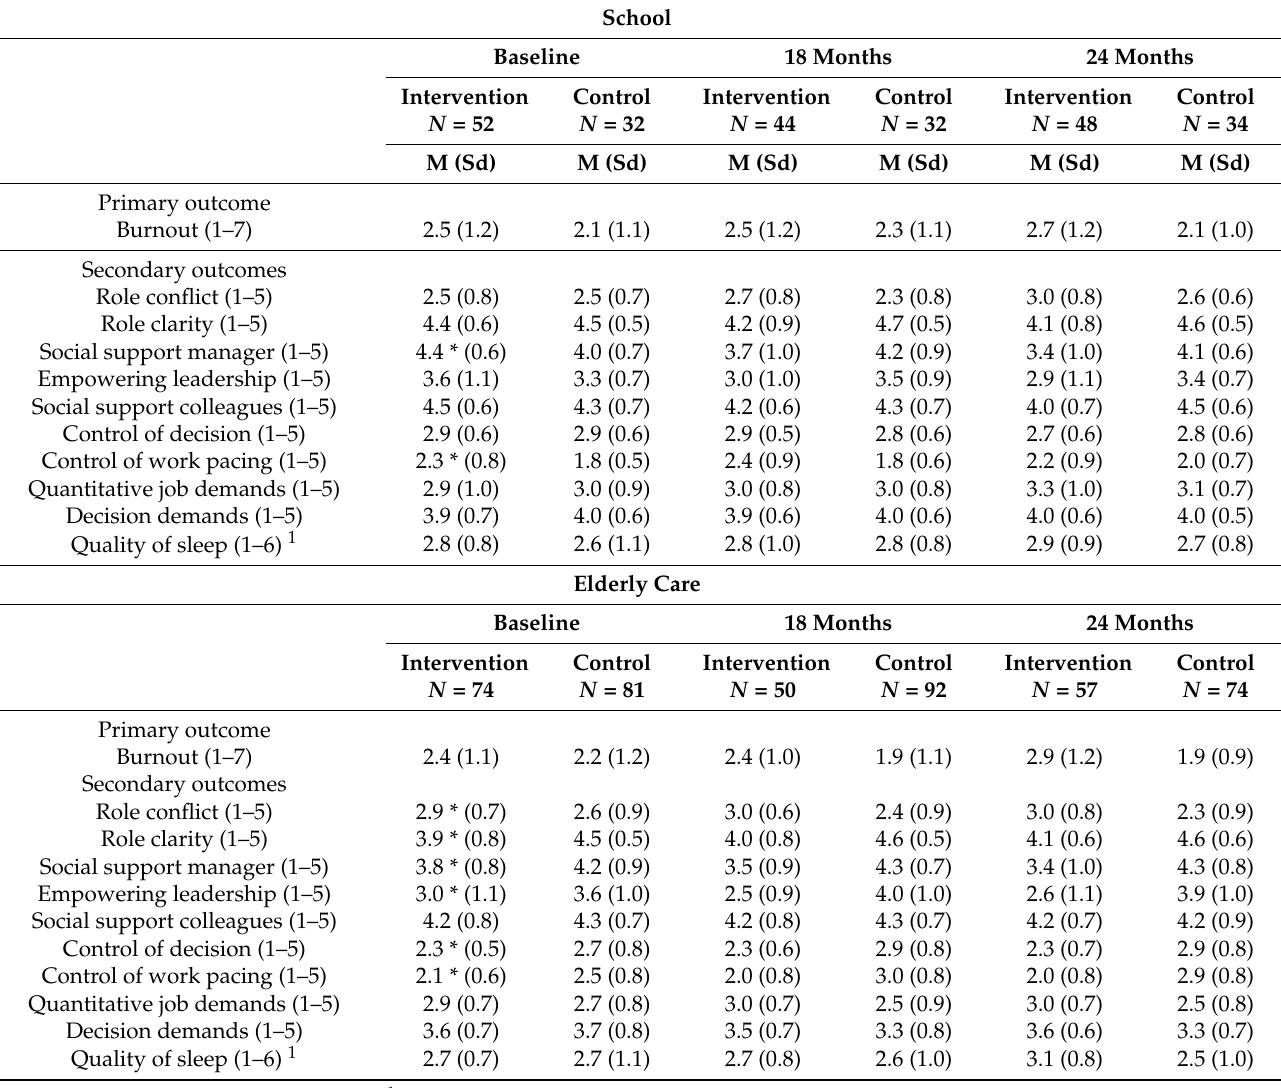
Table 3. Mean and Standard deviation for all outcome variables at all three time